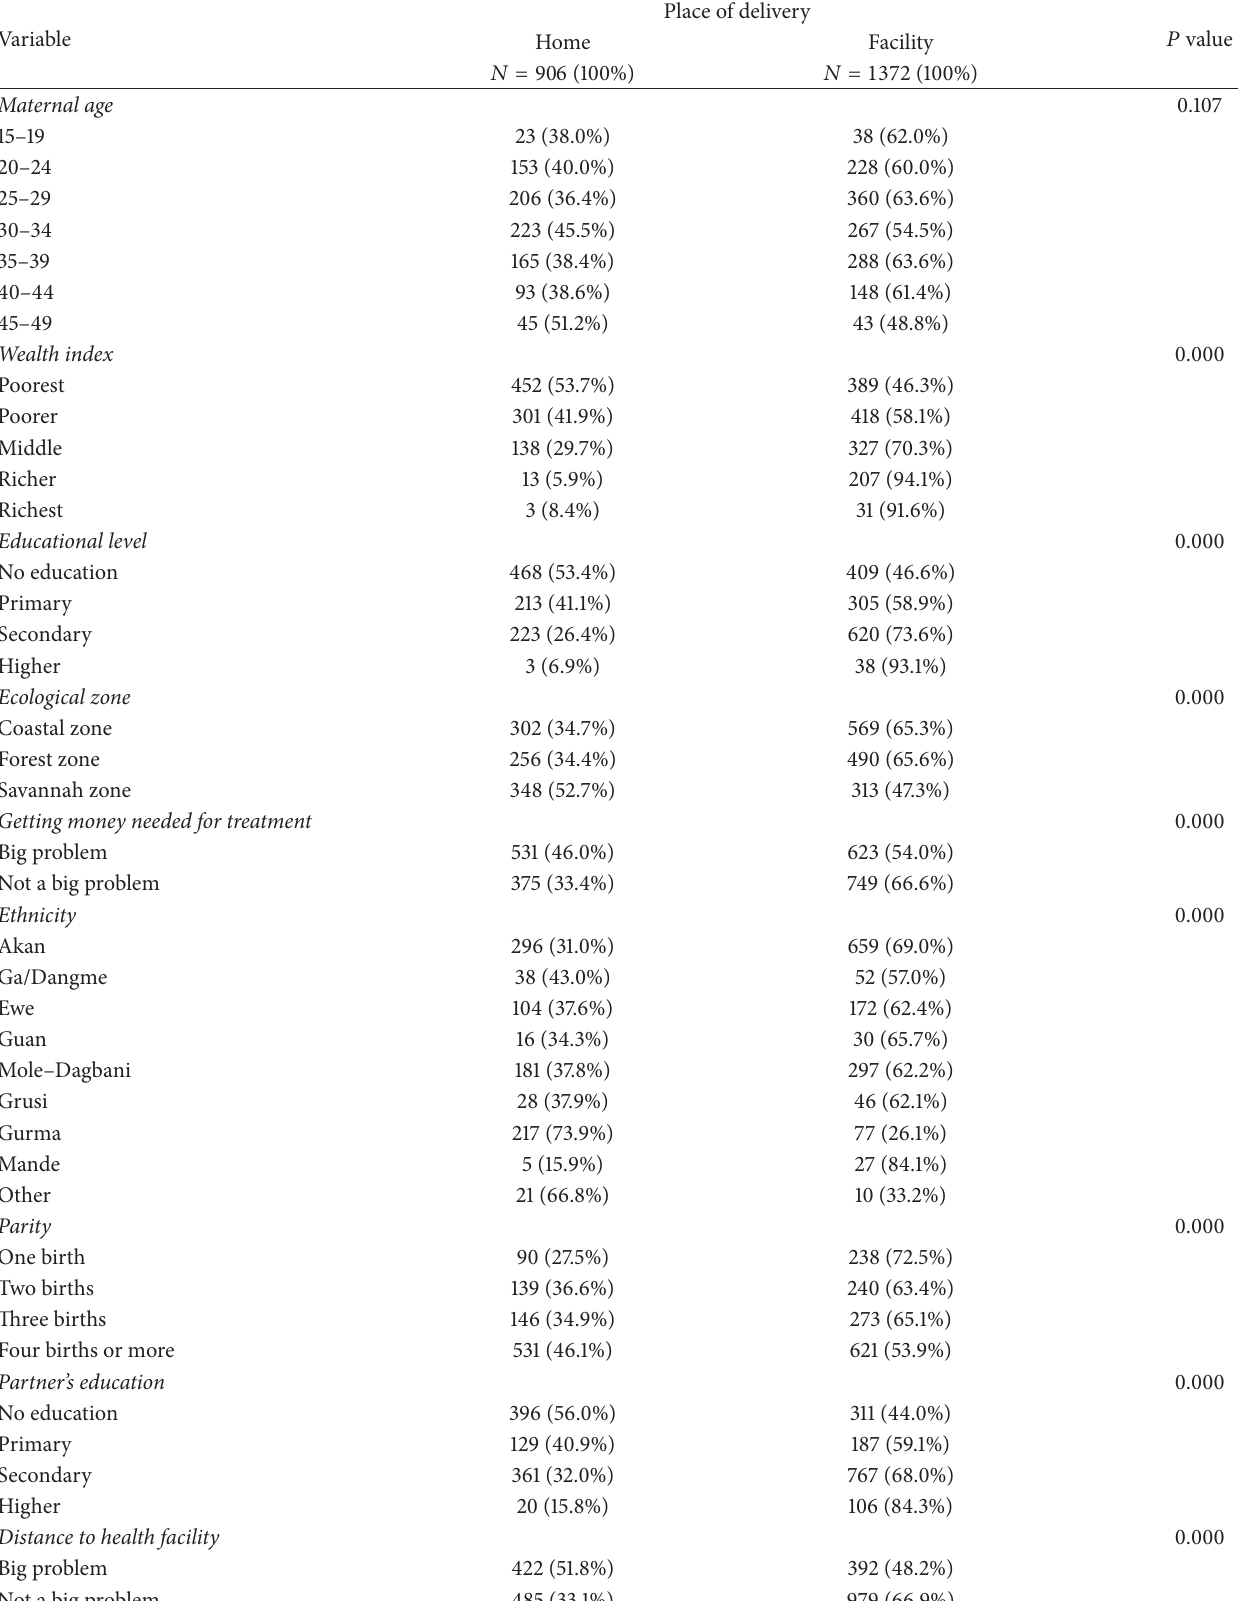
Table 1: Background characteristics and place of